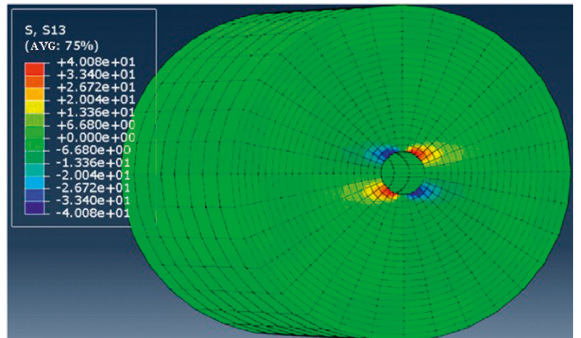
Figure 25: Stress cloud of middle layer S22 in 400% compression shear.